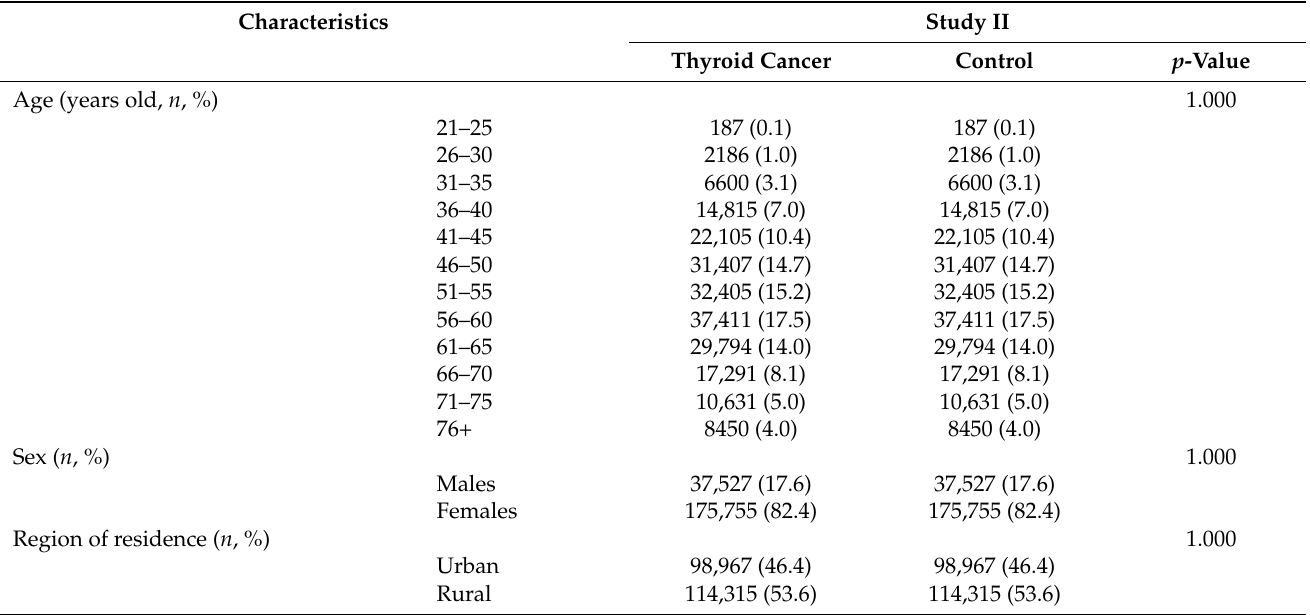
Table 3. General characteristics of participants of Study